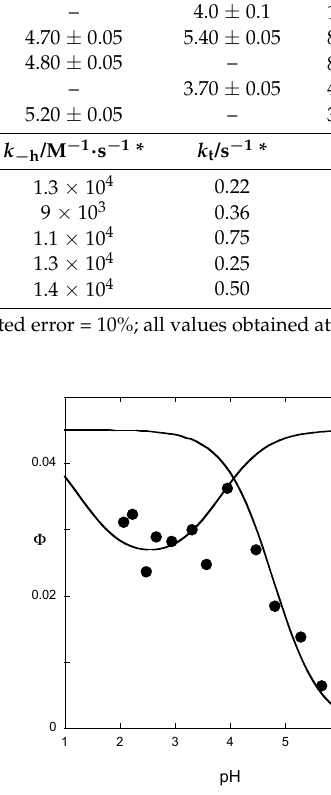
Figure 10. Quantum yield of P5 as a function of pH. Fitting was achieved with Equations (17) and (18) for k i k t / k − h = 1.6 × 10 − 5 M s − 1 ; k i K t /(1 + K t ) = 0.15 s − 1 ; k − h /(1 + K t ) = 9 × 10 3 M − 1 ·s − 1 ; (cid:1863) (cid:2879)(cid:2930)(cid:2892) = 25 M − 1 ·s − 1 ; (cid:1863) (cid:2879)(cid:2930)(cid:2899)(cid:2892) = 2 × 10 10 M − 1 ·s − 1 .